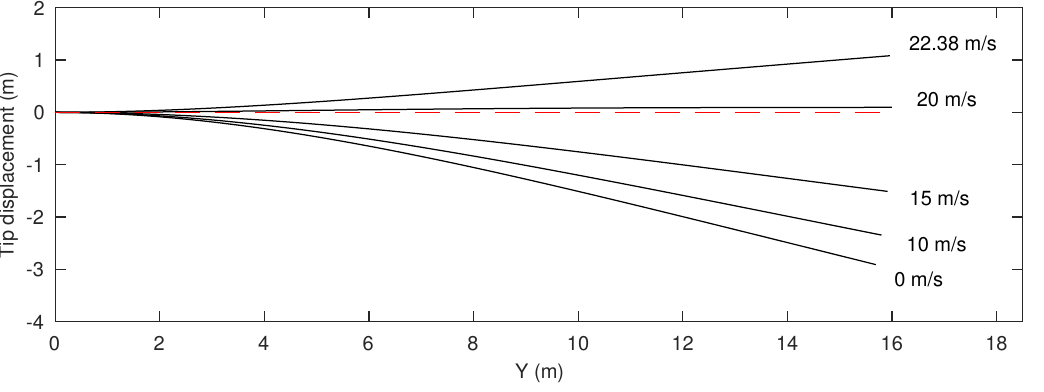
Figure 4. Deflected wing shapes for various airspeeds before flutter.